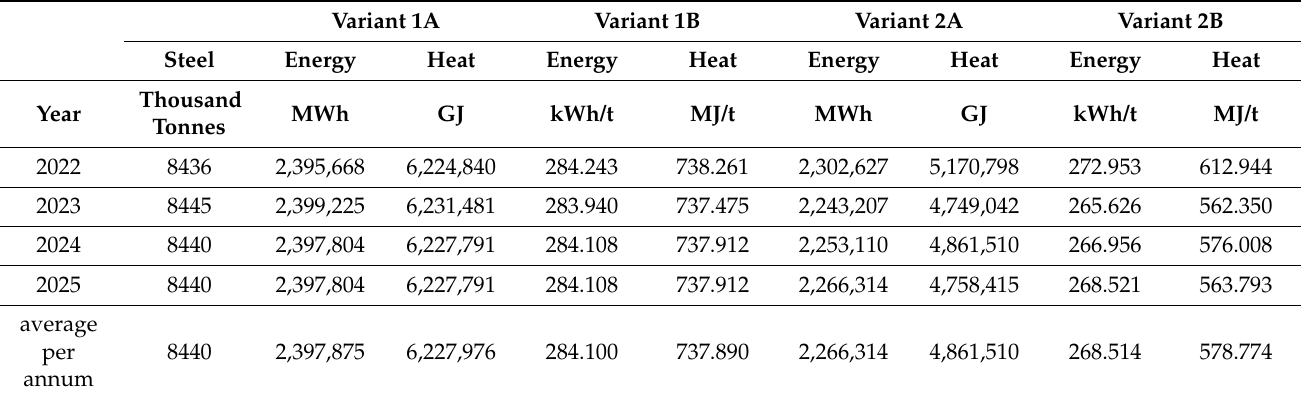
Table 6. Summary of estimated energy and heat consumption for the Polish steel